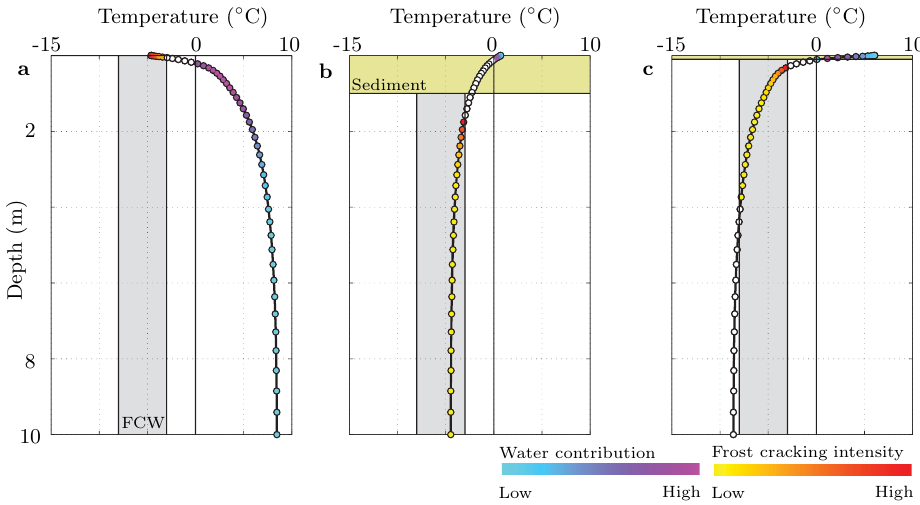
Figure 7. Three examples of temperature profiles under different field scenarios. The circles mark the position of finite-element nodes: blue–violet colours indicate zones that contribute water; red–yellow colours indicate zones with active frost cracking. The grey temperature interval marks the frost-cracking window (FCW). Panel (a) : a warm, bare-bedrock setting with MAT = 8 ◦ C and therefore no permafrost. Frost cracking occurs very close to the surface when temperatures drop into the FCW in winter. Panel (b) : a colder situation with permafrost and MAT within the FCW (MAT = − 4.5 ◦ C). Frost cracking takes place a few metres below the surface at the bottom of the active layer. By providing water the sediment cover (yellow fill) promotes frost cracking until the sediment thickness exceeds the active-layer thickness. Panel (c) : a situation with extensive permafrost and MAT below the FCW (MAT = − 8.5 ◦ C). Frost cracking is now most active close to the surface in summer. Again, because water must come from above the FCW, a thin sediment layer amplifies frost cracking. The white circles are nodes that are outside the FCW and that do not contribute